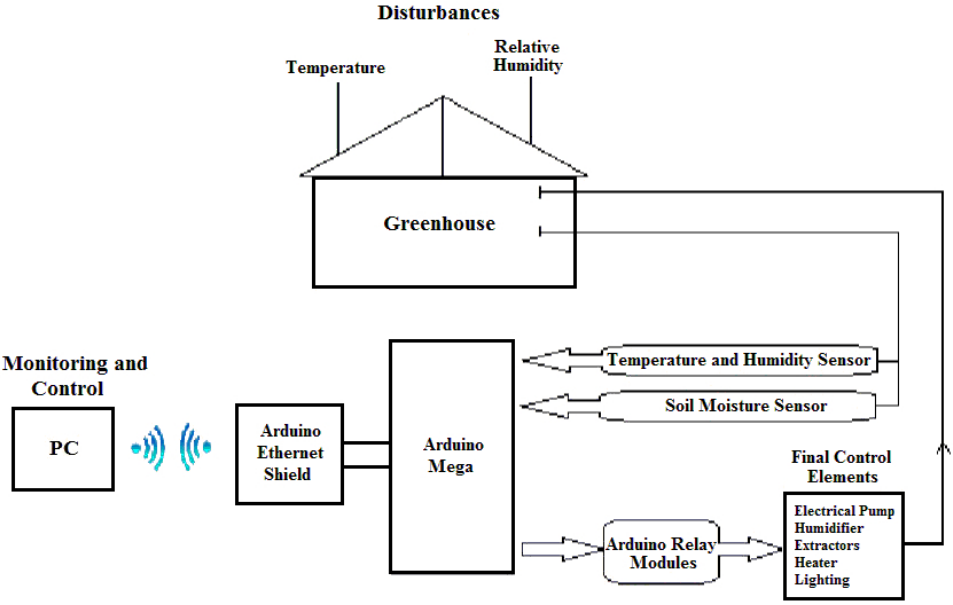
Figure 1. Block diagram of the system.